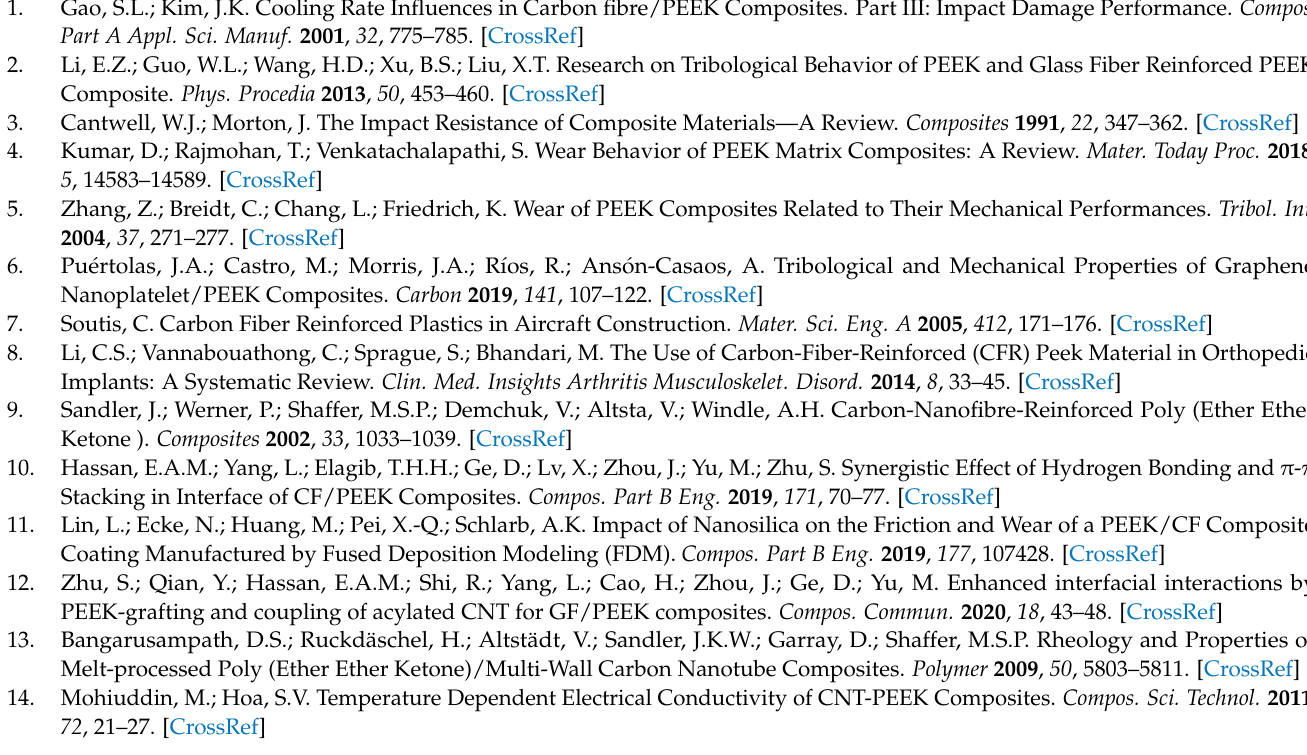
composite., Figure S4: DSC curves (melting) of the neat PEEK and sample PEEK–GnP0.5, PEEK– GnP1.0 and PEEK–GnP3.0, Table S1: Crystallite size of the neat PEEK and PEEK/GnP